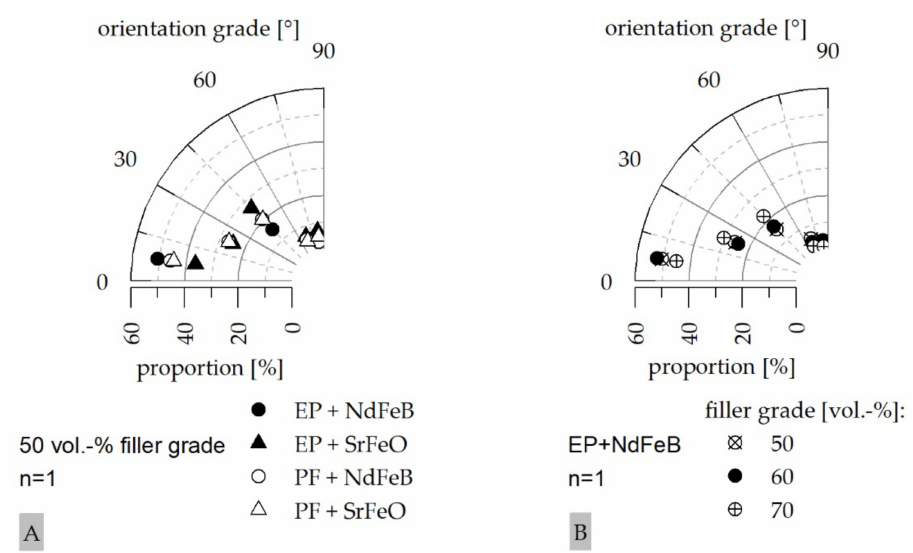
Figure 12. Orientation grade relative to different matrix materials and fillers ( A ) and filler grades in EP with NdFeB ( B ) (SrFeO: strontium-ferrite-oxide; NdFeB: neodymium-iron-boron; PF: phenolic resin; EP: epoxy